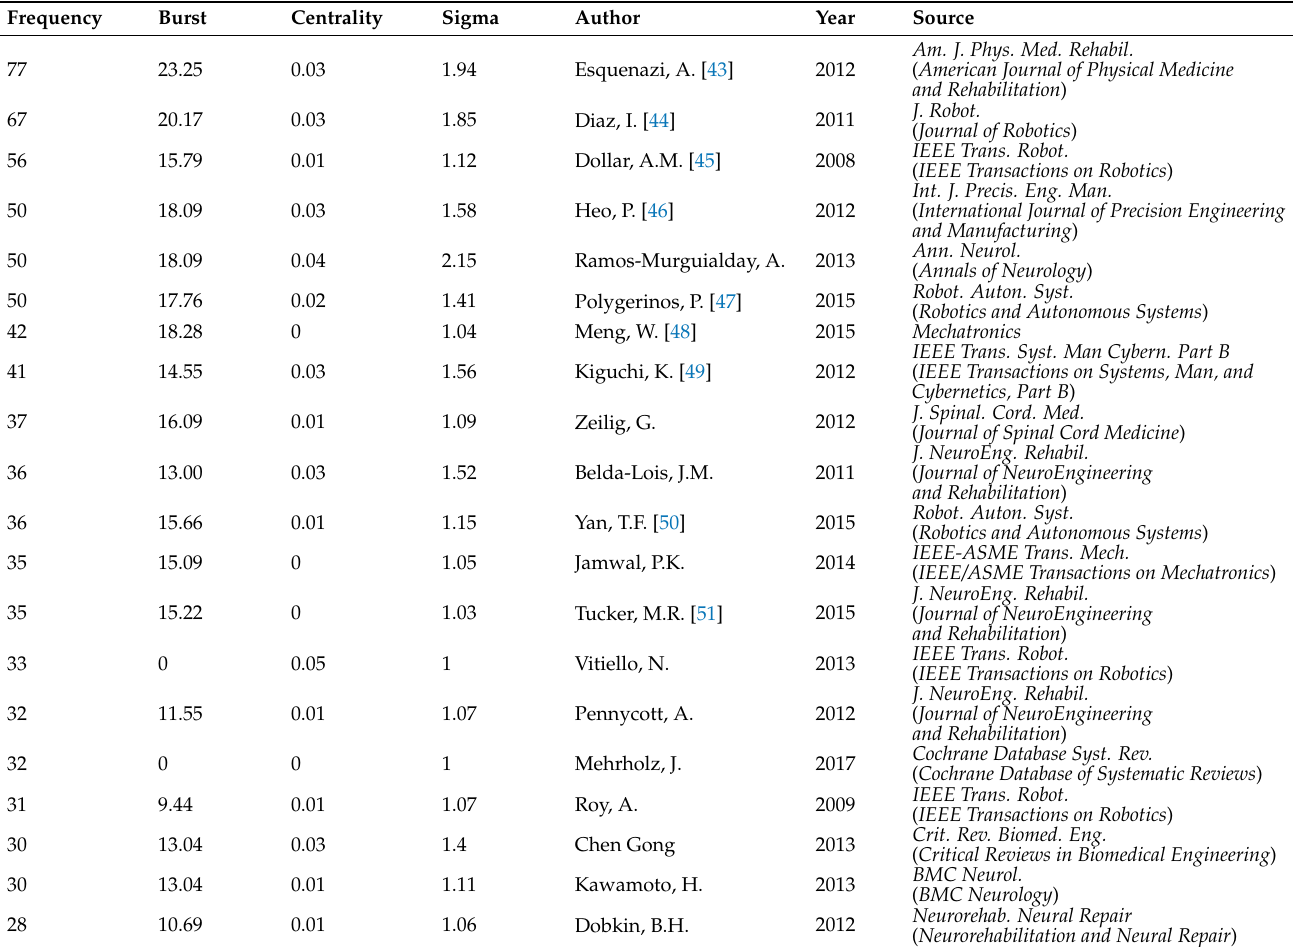
Table 4. Cited references in cluster